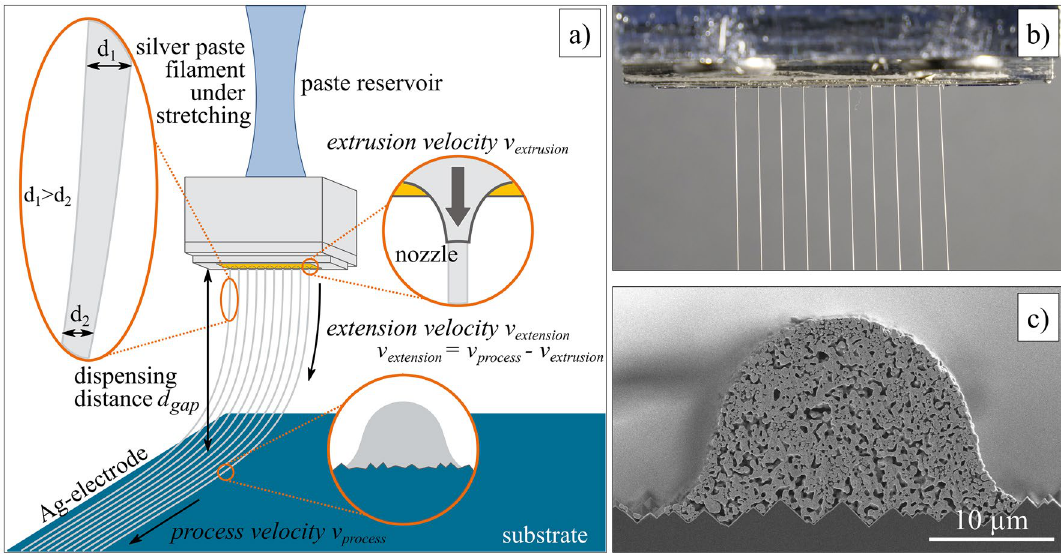
Figure 1. Overview on the parallel dispensing approach for solar cell metallization. ( a ) Illustration of filament stretching during micro-extrusion of low-temperature curing Ag pastes. The print head is positioned above the substrate with the dispensing gap d gap ; in this gap the filament stretching occurs. The paste threads are stretched from the initial diameter d 1 to a smaller diameter d 2 . The extensional velocity v extension is determined by the difference in process velocity v process and the extrusion velocity v extrusion (figure according to 13 ). ( b ) Simultaneous extrusion of ten paste threads through 35 µm nozzle openings. A uniform paste distribution inside the print head ensures a homogeneous paste extrusion 8,25 . ( c ) Scanning electron microscope (SEM) image of a